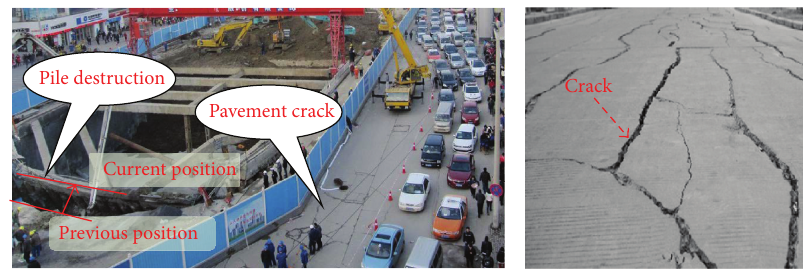
Figure 1: Typical example of pit destruction [16].